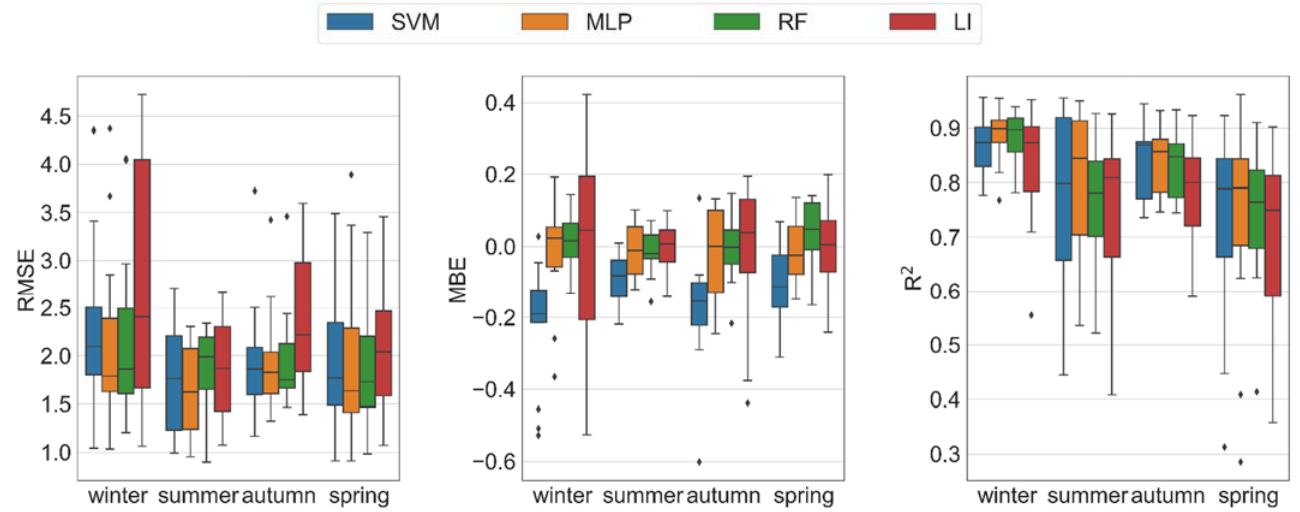
Figure 8. Seasonality performance of the different models (SVM, MLP, and RF) in all the stations and approaches .